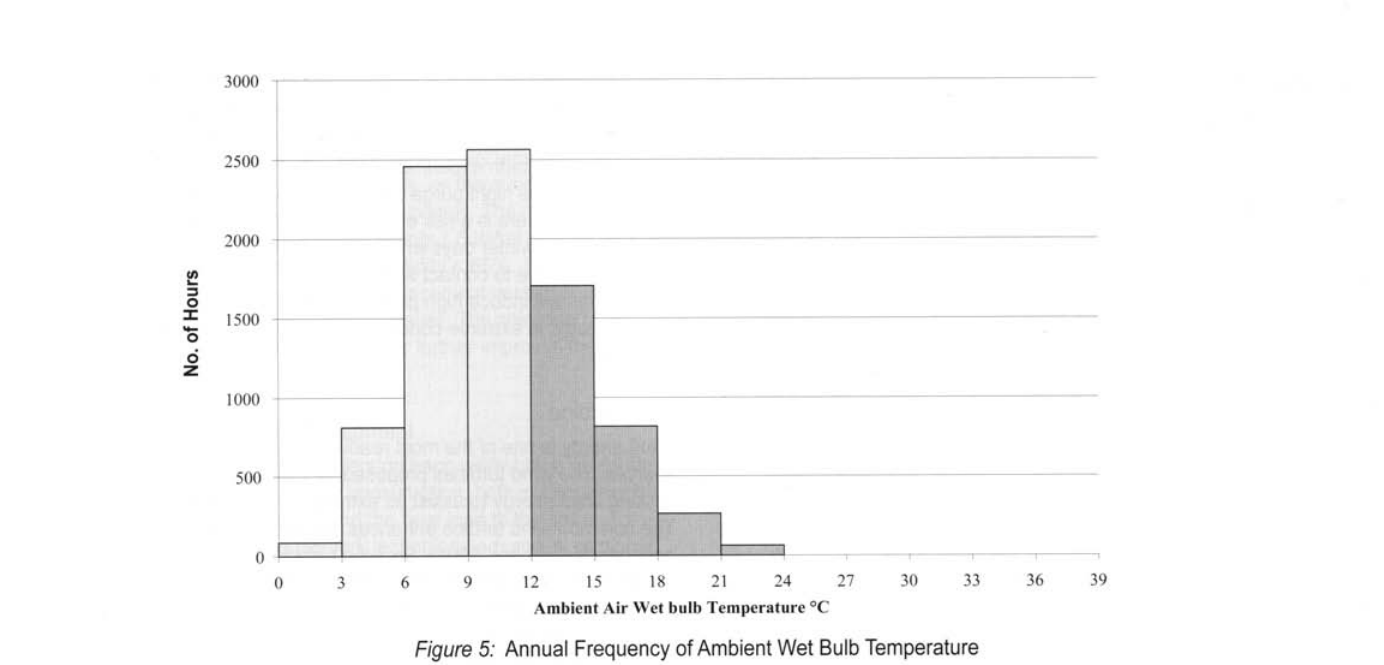
Figure 5: Annual Frequency of Ambient Wet Bulb Temperature